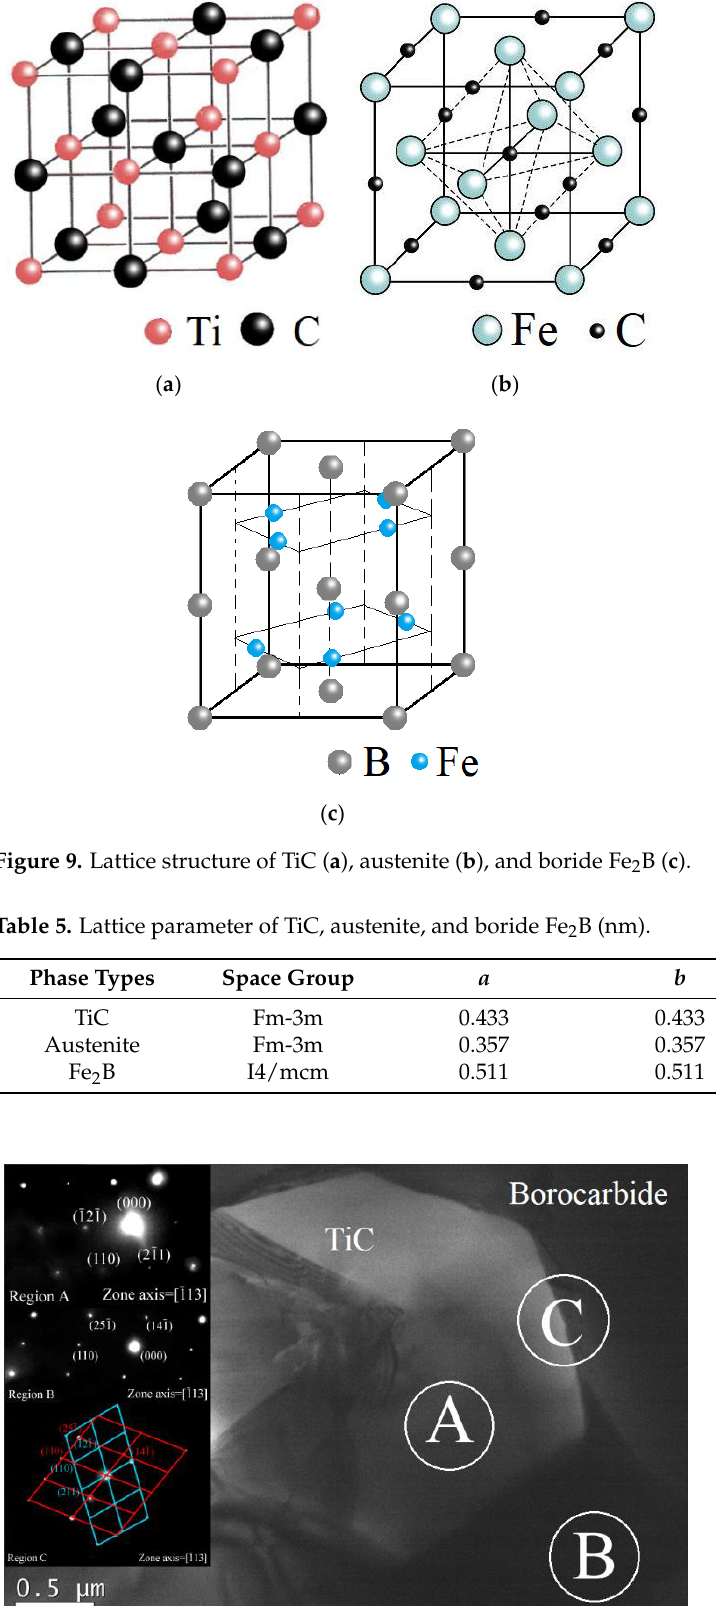
Figure 10. TEM bright field of TiC and M 2 (B,C) with corresponding selected area (electron) diffraction (SAD) patterns.